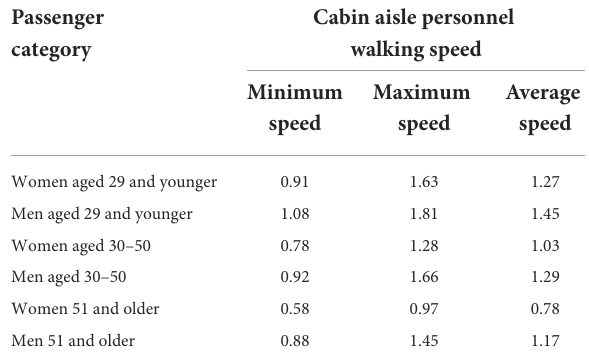
TABLE 6 The empirical formula for the walking speed of personnel on the level ground (22).